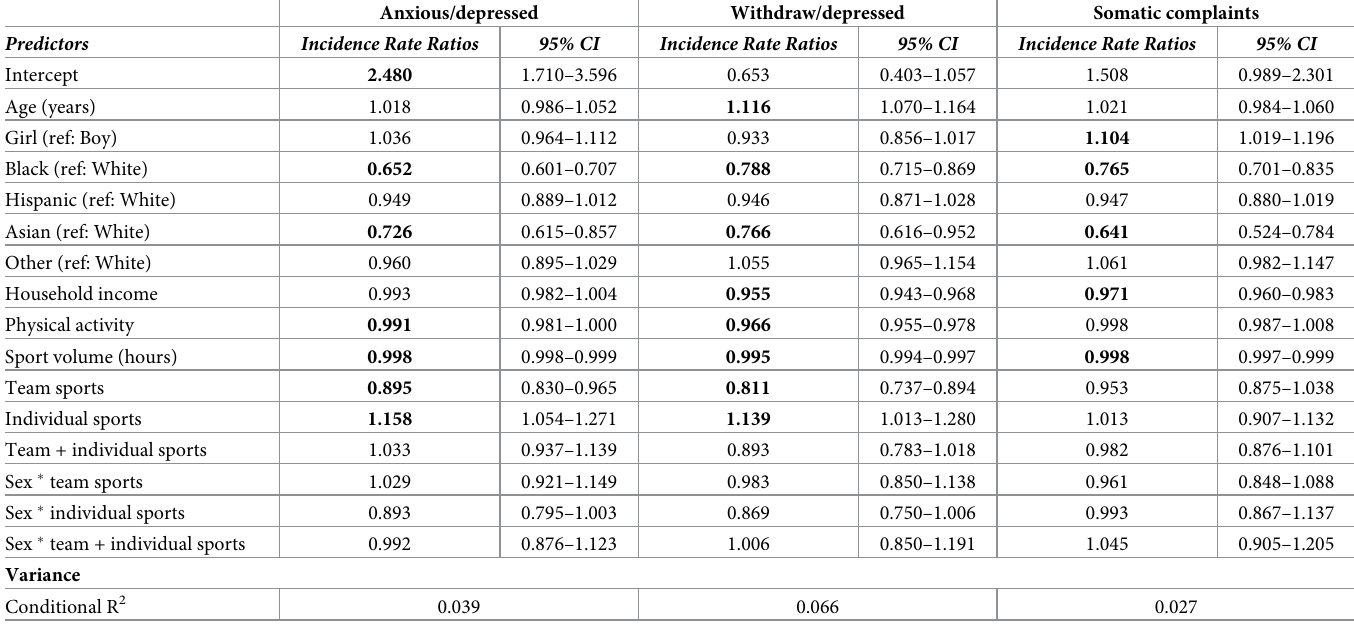
Table 3. Associations between types of sport participation and mental health difficulties.